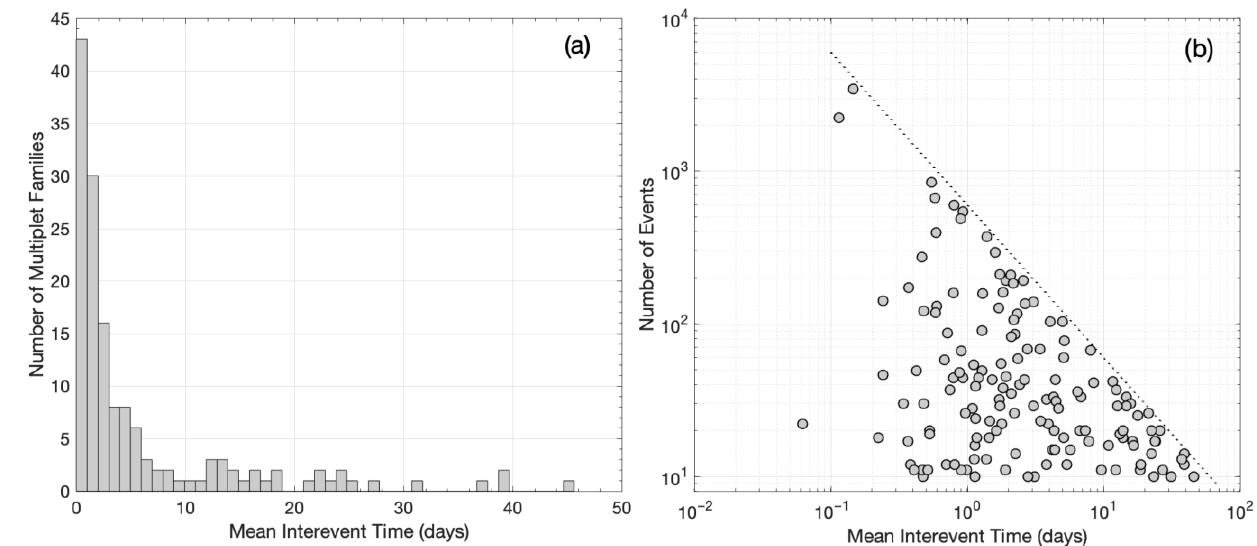
Figure 11. ( a ) Histogram of the mean inter-event times (in days) for the multiplet families with at least 10 events ( N ≥ 10). ( b ) The number of events in each multiplet family as a function of its mean inter-event time (in days). The dotted line shows an inverse power law function with slope –1.